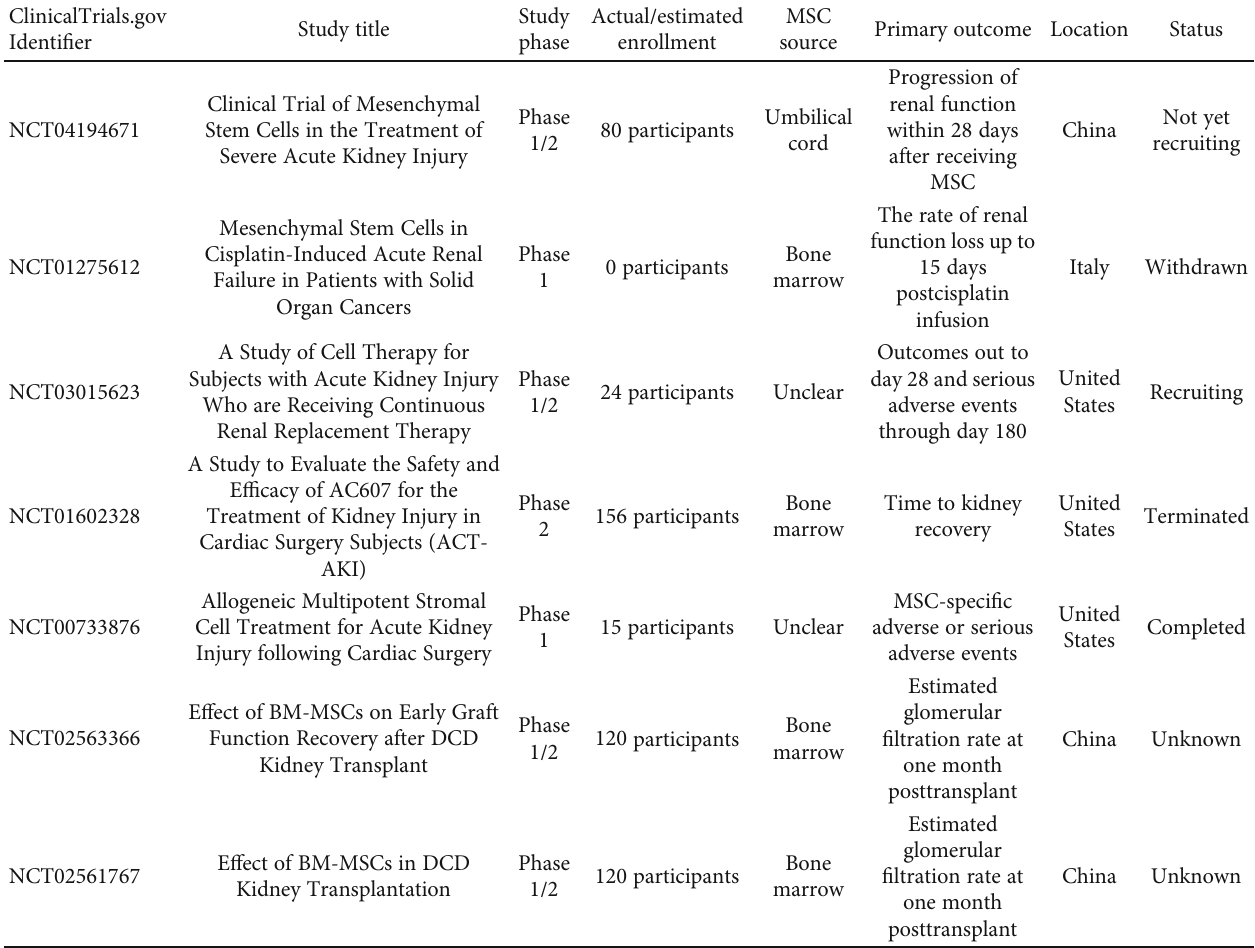
Table 1: Registered clinical trials involving the use of MSCs in